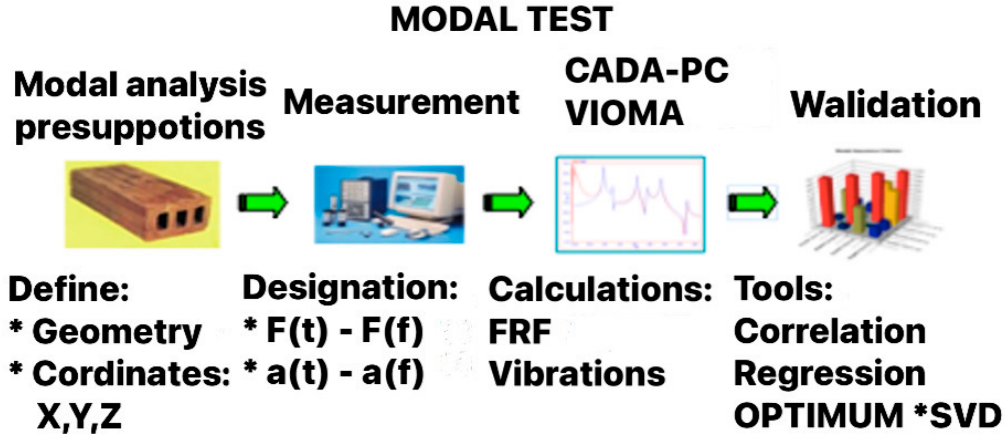
Figure 6. The essence and scope of research in operational modal analysis.